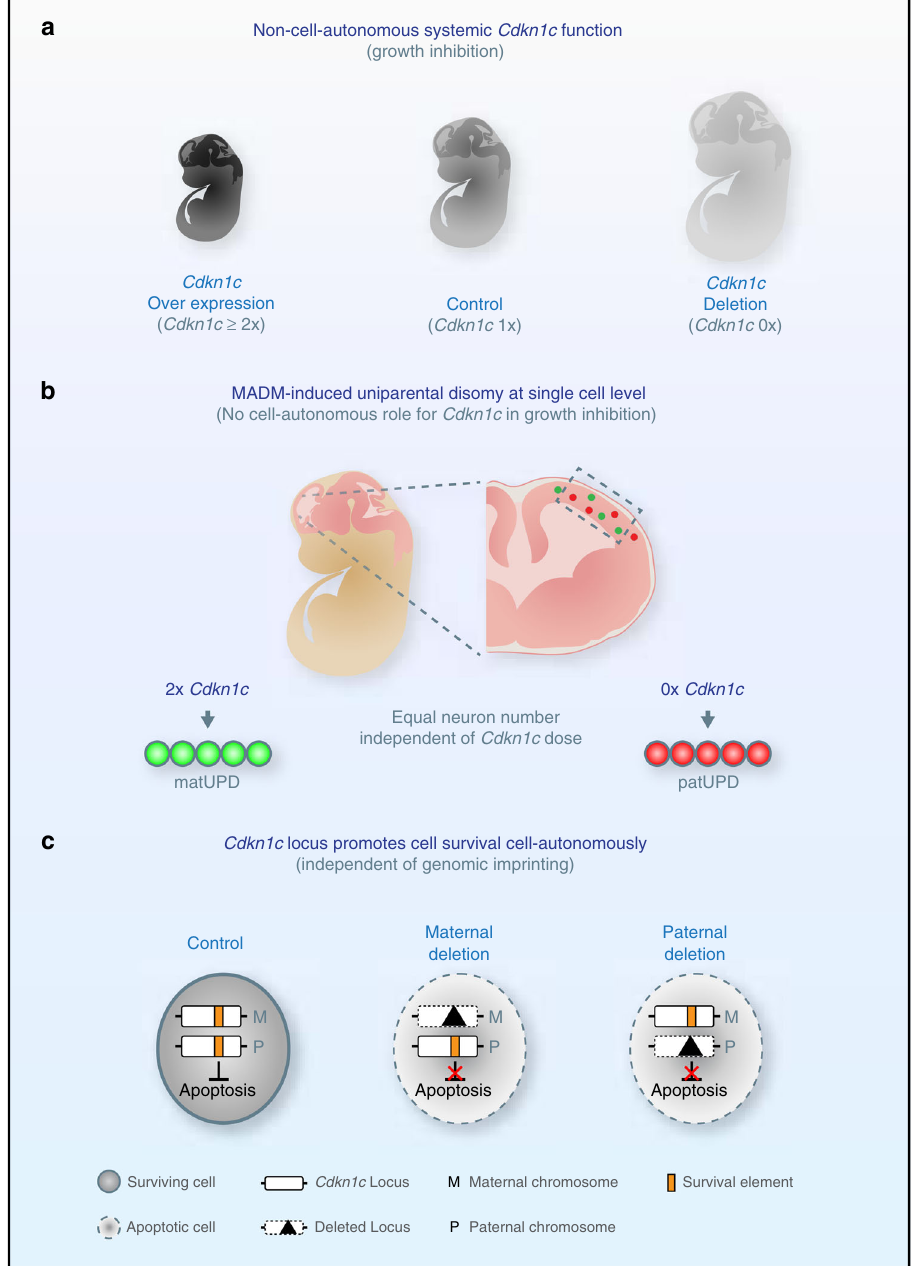
Fig. 7 Schematic of Cdkn1c locus functions in cerebral cortex growth and development. a Previous studies 41 – 44 have established that twofold or higher systemic (whole animal) expression of Cdkn1c (2×, dark gray) results in embryonic growth inhibition when compared to wild-type embryos with imprinted expression of Cdkn1c (1×, gray) whereas global knockout of Cdkn1c (0×, light gray) results in embryonic overgrowth 14,45 . b Analysis of single cells with MADM-induced uniparental chromosome disomy (UPD) (twofold overexpression (green cells) or no expression of Cdkn1c (red cells)) in an otherwise wild- type environment indicates no cell-autonomous function for Cdkn1c in cortical growth regulation. c Conditional Cdkn1c locus deletion and analysis at single- cell resolution revealed a putative survival element (SE) acting in a dosage-sensitive manner but which is not subject to genomic imprinting. Deletion of either the maternal or paternal Cdkn1c locus leads to p53-mediated